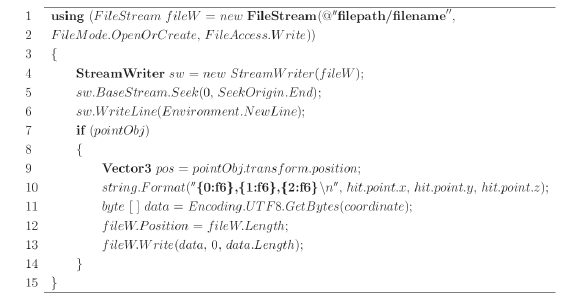
Figure 5. Roaming in Logistics